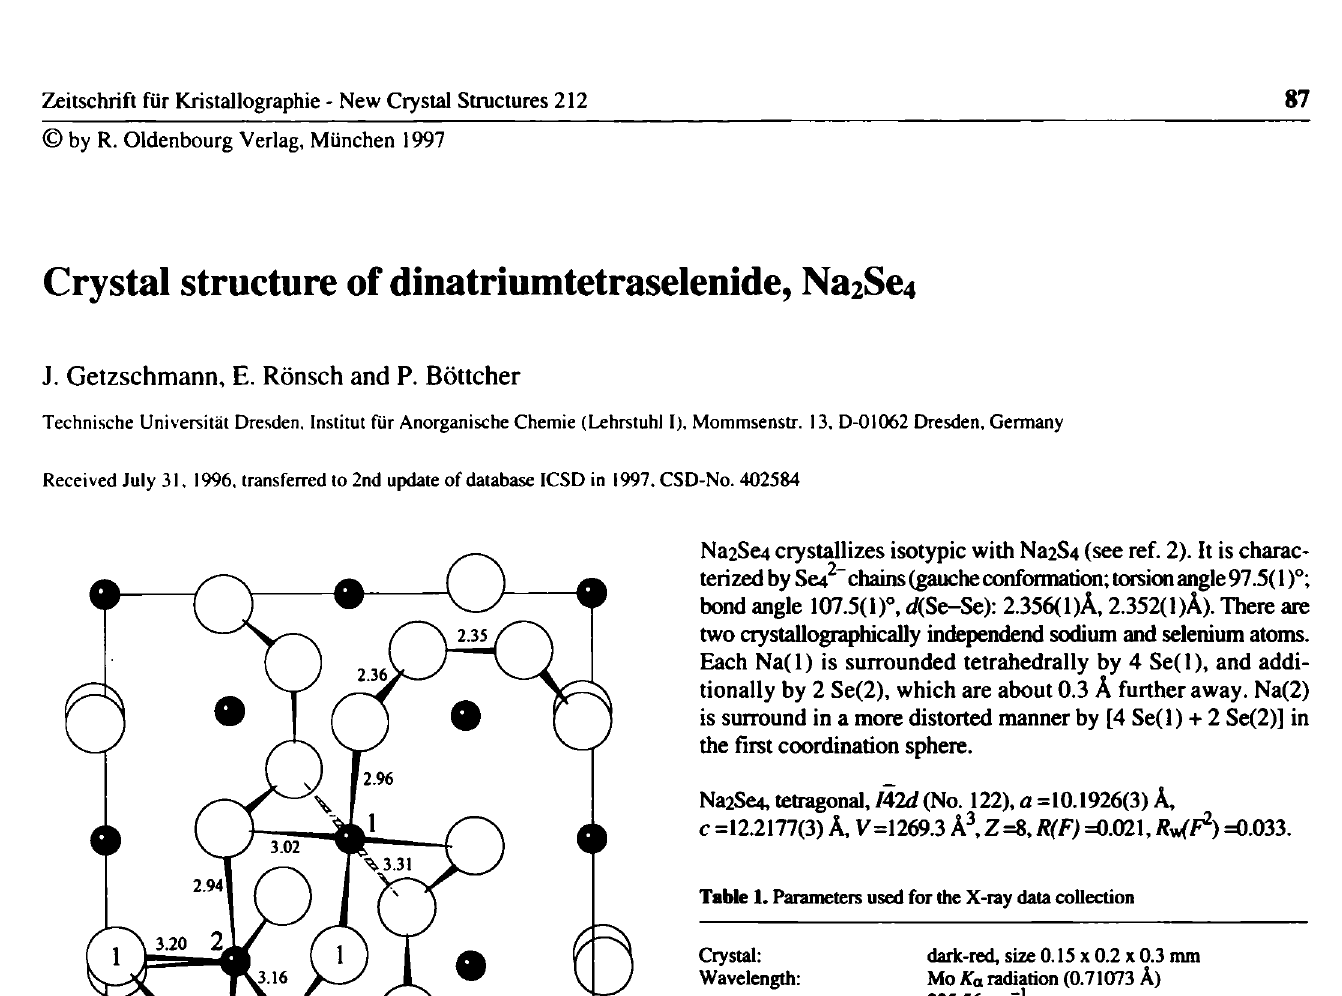
Table 1. Parameters used for the X-ray data collection